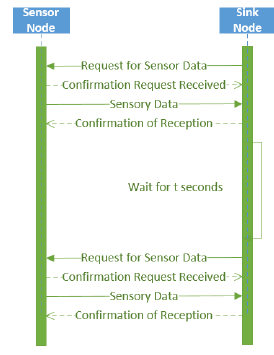
Figure 6. Active wireless sensor node communication with the sink node.